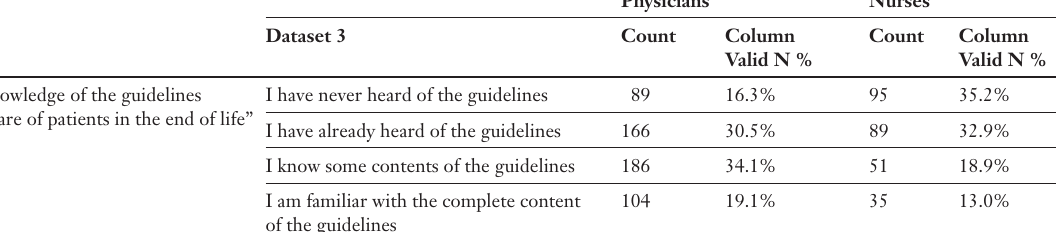
Knowledge of the guidelines “Determi- nation of death in the context of organ